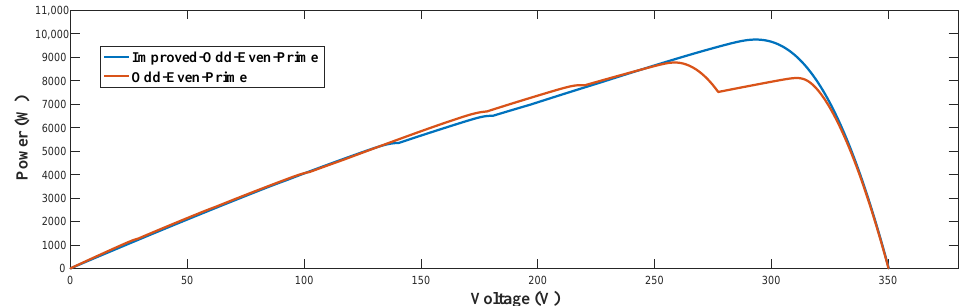
Figure 23. Voltage–power characteristics of 8 × 9 PV array for case-IV (Bottom-Right) PSC. 3.2.5. Case-5 (Top-Left and Bottom-Right) Shading Case-5 is a combination of case-1 and case-4, i.e., in case-5 both Top-Left and Bottom- Right PSC have been considered. In case-5, a total of 32 PV modules were subjected to PSC, as shown in the Figure